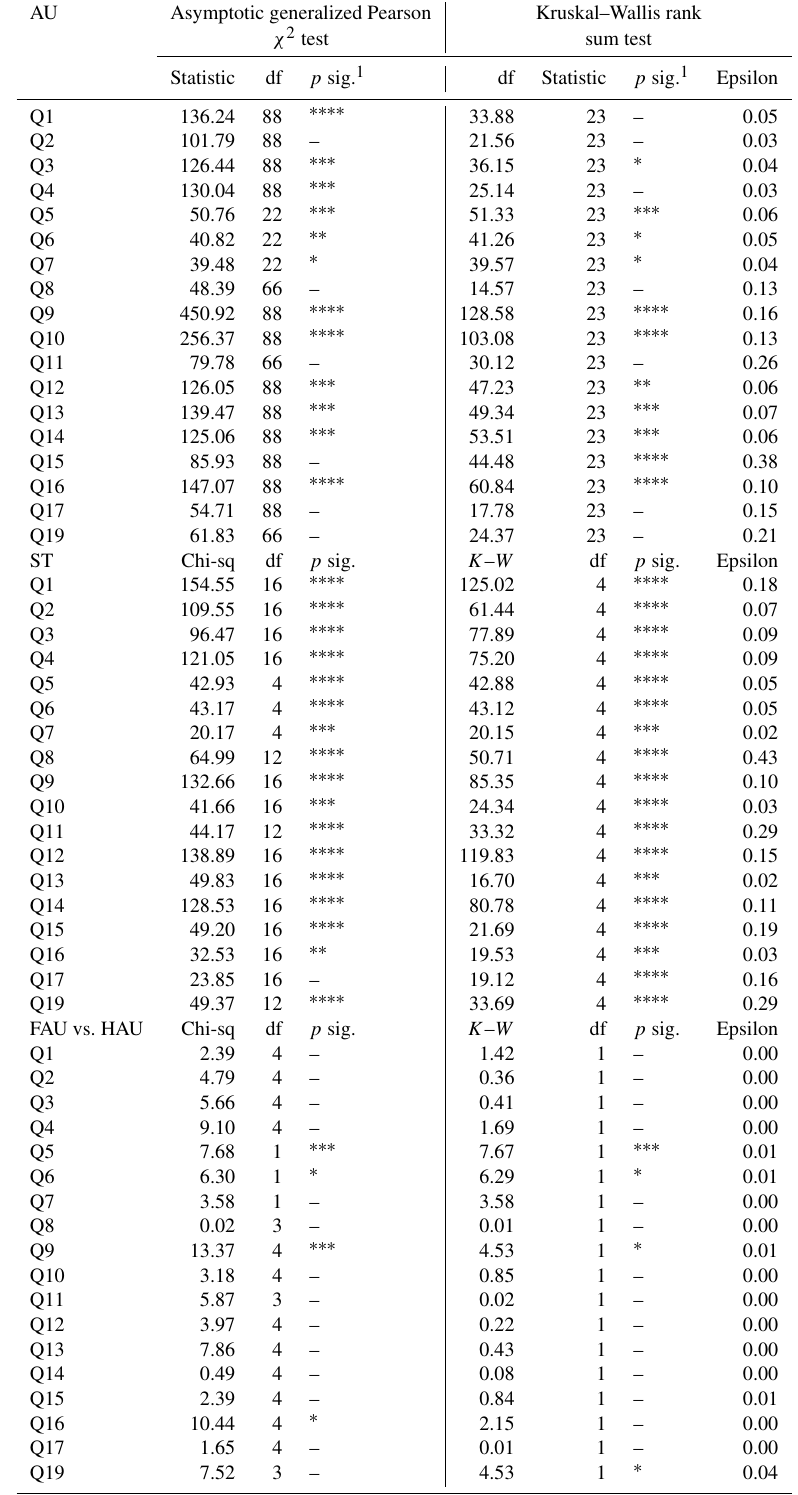
Table A2. The non-parametric-test results for stakeholder types (STs), administrative unit (AUs), and floodplains vs. hilly areas (FAUs vs.